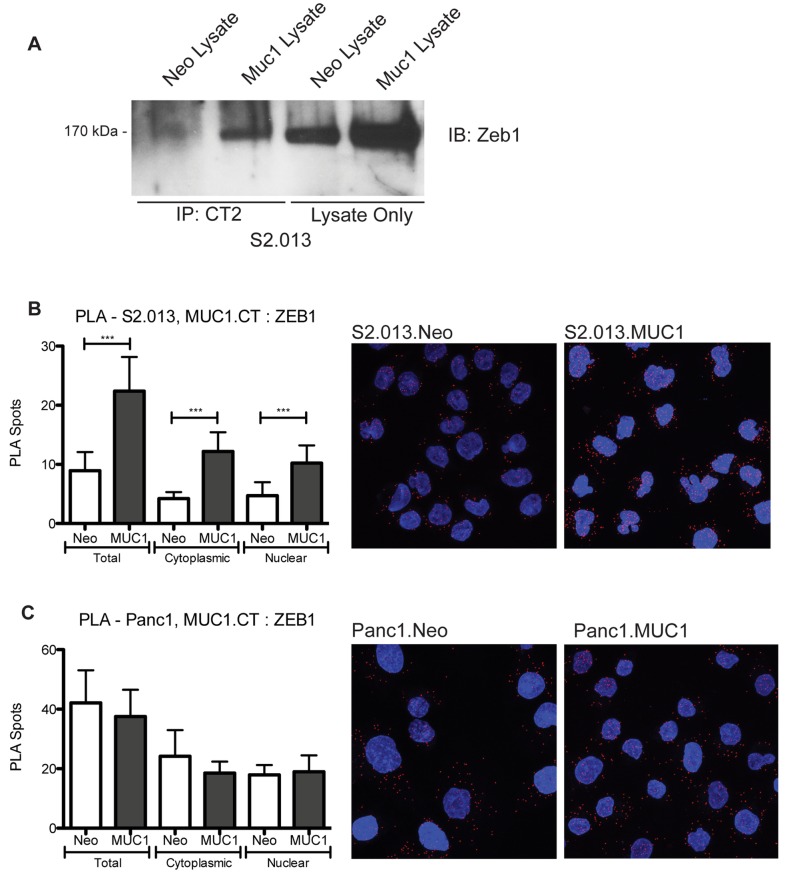
MUC1.CT directly interacts with transcriptional repressor ZEB1.A) Co-immunoprecipitation (Co-IP) was utilized to evaluate the interaction of the MUC1.CT and ZEB1 in S2.013.Neo and S2.013.MUC1 cells. Cell lysates were immunoprecipitated with an antibody against the MUC1.CT, and the subsequent western was blotted with an antibody to ZEB1. Non-immunoprecipitated lysates were used as a loading control, and steady state levels of ZEB1 were higher in S2.013.MUC1 cells compared to S2.013.Neo cells. B-C) Proximity ligation assay (PLA) was used to visualize MUC1.CT and ZEB1 interaction in S2.013.Neo and S2.013.MUC1 cells, B, and Panc1.Neo and Panc1.MUC1 cells, C (with representative compressed z-stack image for each). These data show quantitative levels of MUC1.CT and ZEB1 interactions, indicating that MUC1.CT and ZEB1 interact in both cell lines. In the S2.013.Neo and S2.013.MUC1 cell lines, the interaction was significantly higher in the MUC1 expressing cells, confirming the Co-IP in A. However, there was no significant difference in interaction in the Panc1.Neo and Panc1.MUC1 cells. (Student’s t-test: *** p < 0.0005).